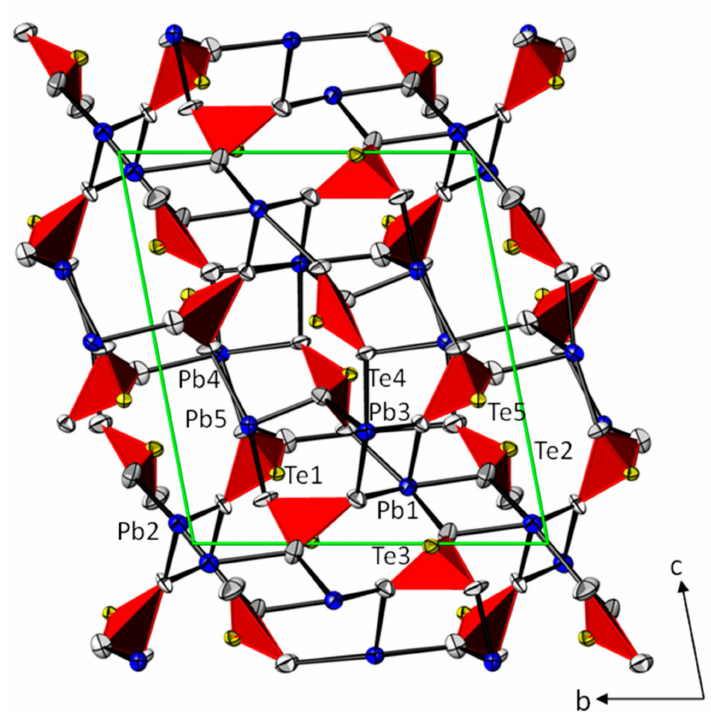
Figure 2. The crystal structure of γ -PbTeO 3 in a projection along [100]. TeO 32 − anions are given in polyhedral representation with Te IV atoms in yellow and O atoms in white. Displacement ellipsoids are as in Figure